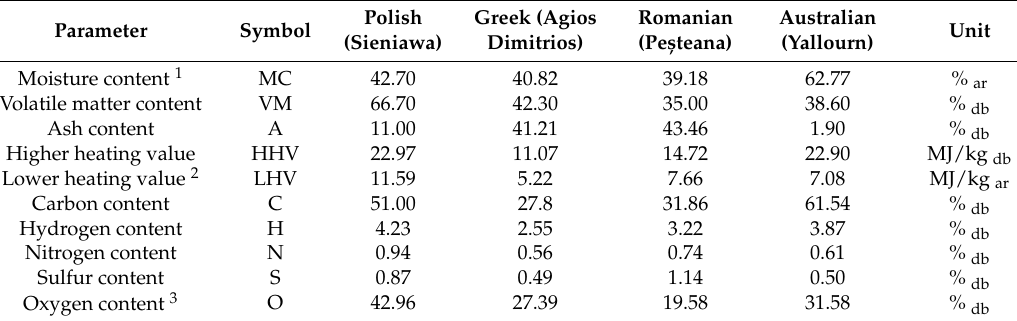
Table 1. Proximate and elemental analysis of tested